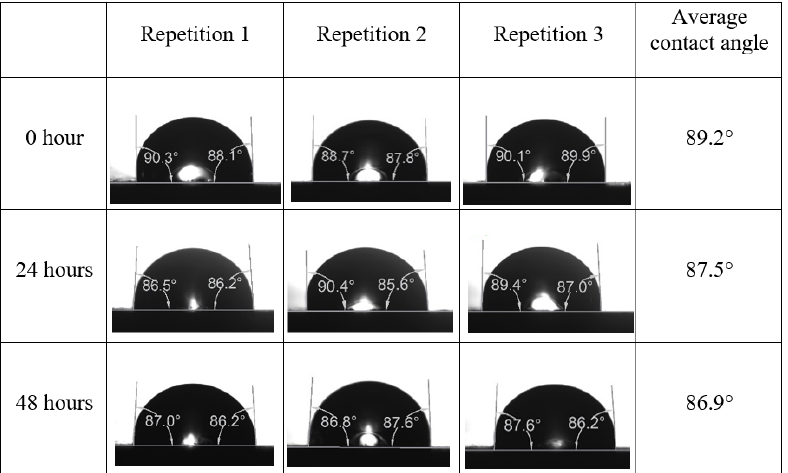
Figure A12. Dynamic Contact Angle Measurement Results for 25% MgCl 2 + 75% CaCl 2 (3500 ppm).